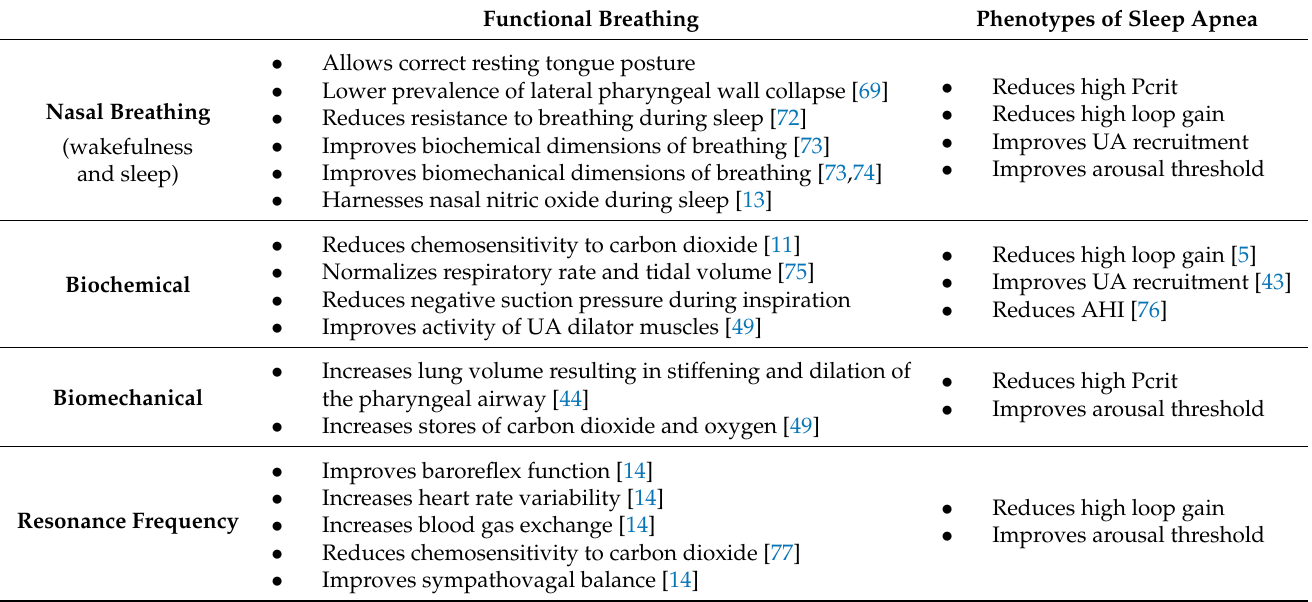
Table 1. Functional breathing and phenotypes of OSAHS: different hypotheses (UA = upper airway). Functional